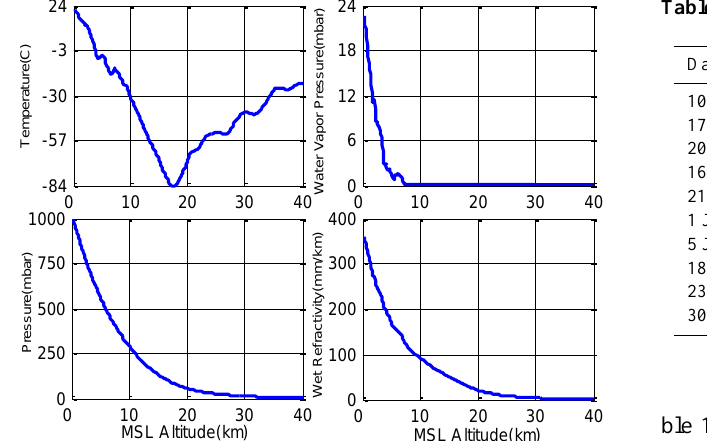
Table 1. COSMIC RO events near Hong